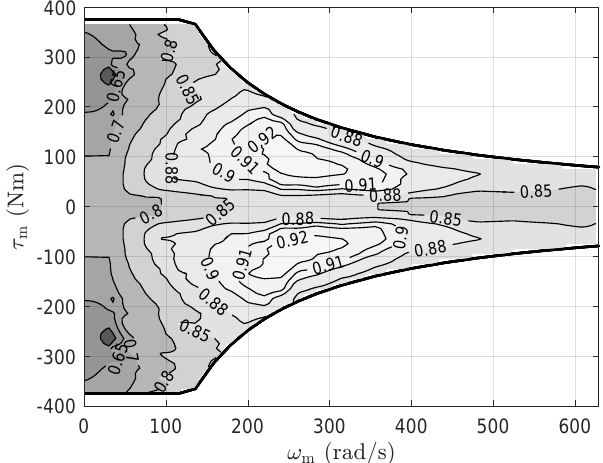
Figure 3. Efficiency map of PMSMused for scaling the electric machine efficiency with the peak power [31]. The map includes both machine and inverter efficiencies. Peak efficiency η = 50 kW, maximum torque τ m = 375 Nm, maximum speed ω m = 629 rad/s, and base power P m k ,base speed ω m,b = 116